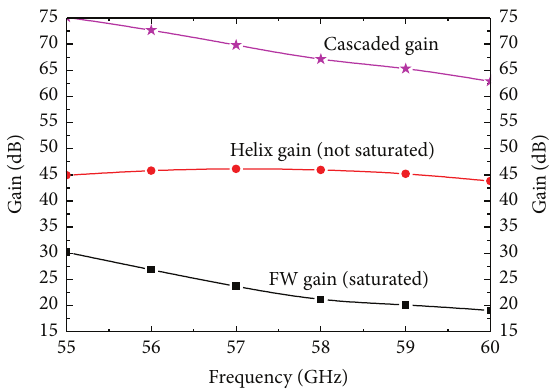
Figure 13: Cascaded gain, helix gain, and FW gain curves in